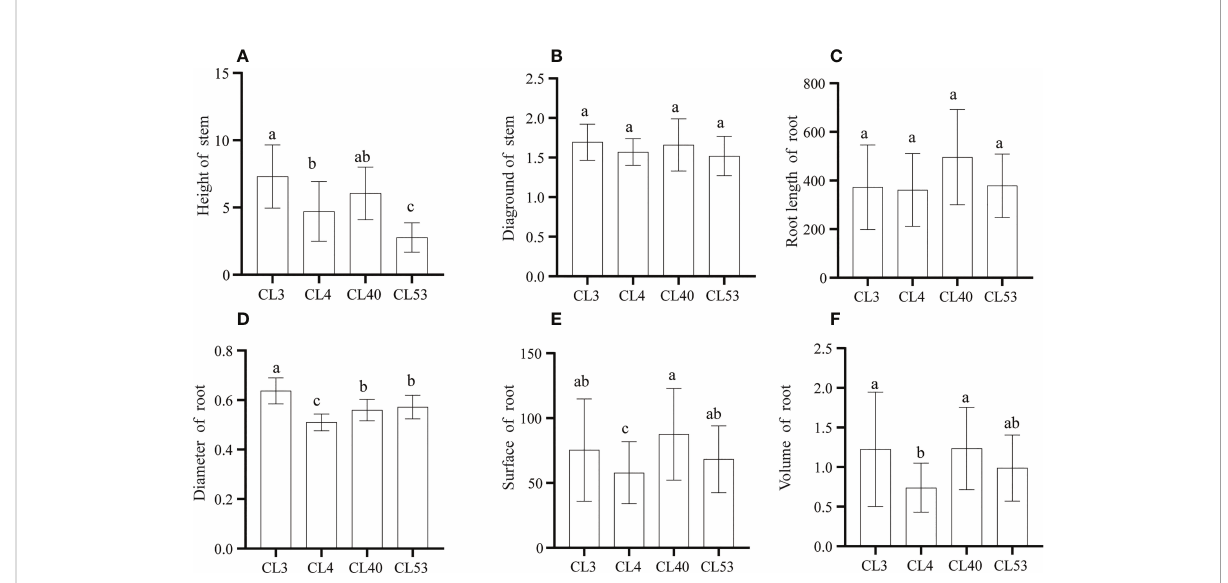
FIGURE 2 The growth of stem and root after grafting in C.oleifera. (A) Height (cm). (B) Diaground (mm). (C) Root Length (mm) (D) Root diamter (mm) (E) Root surface (mm2). (F) Root volume (mm3). Data represent the average of three replicates (n = 3) = standard error. Different letters indicate signi fi cant differences by Duncan's Multiple Range Test at p< 0.05. Height: seedling height. Diaground: ground diamter. Length: total root length. Surface: root surface. Avgdiam: average